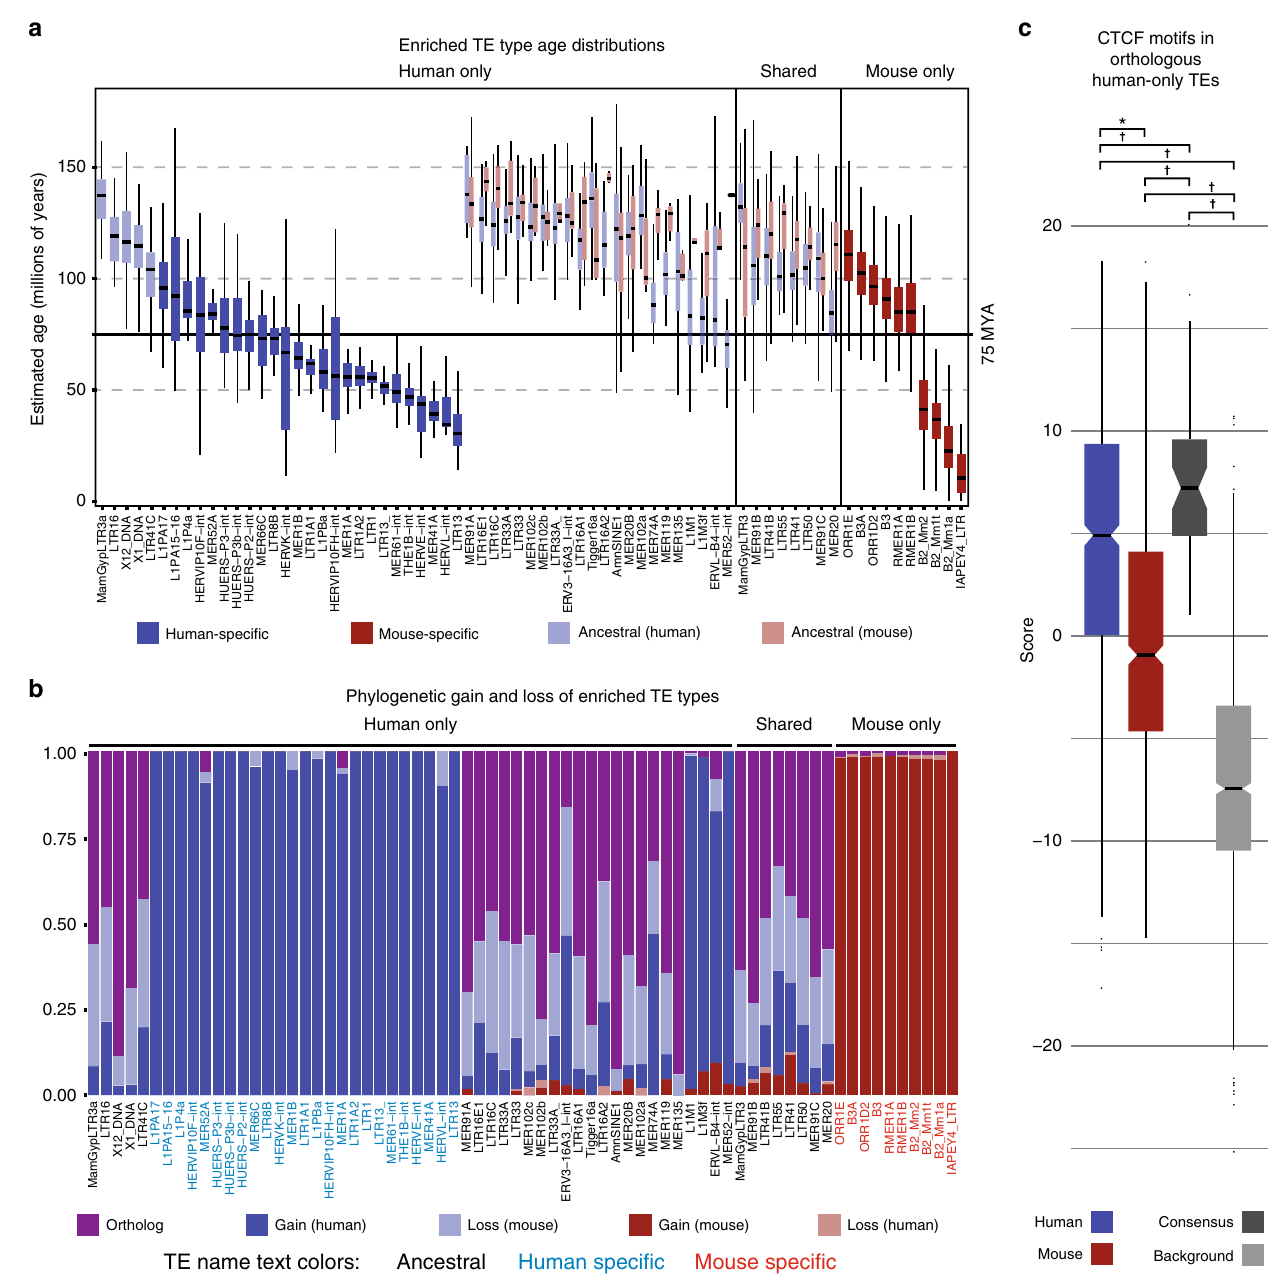
Mouse specificHuman specificTE name text colors: Fig. 3 Ages and phylogenetic histories of human-only CTCF-enriched TEs support mouse-speci fi c loss-of-function. a Estimated age distributions for CTCF-bound TE insertions of enriched types. Colors indicate the species-speci fi city of each TE type and score distributions are split by species where applicable. The solid black horizontal line marks the estimated primate – rodent divergence date. b Fraction of enriched TE insertions inferred as orthologous, or as evolutionary gains or losses on a given branch of the phylogeny. TE label colors indicate whether the given type is ancestral (black), human-speci fi c (blue), or mouse-speci fi c (red). c Maximum CTCF motif scores within human and mouse instances of ancestral, human-only TE types. TE Consensus sequences (a proxy for the ancestral TE sequence, dark gray) and length-matched background sequences (light gray) are shown for comparison. Log-odds scores greater than 1 indicate sequences matching the CTCF motif more than expected by chance. Hypothesis tests were used to assess signi fi cance of differences in all pairwise comparisons: * p < = 2.9e − 58 (one-sided Wilcoxon signed-rank test), † p < = 2.6e − 4 (one-sided Wilcoxon rank-sum test). Human, n = 852; mouse, n = 852; consensus, n = 54; background, n = 852. Boxplots in a and c are centered around the median, with upper and lower hinges, indicating the fi rst and third quartiles. Upper and lower whiskers extend from the hinge to the largest and smallest values within 1.5× the inter- quartile range from the hinge. Individual data points beyond the ends of the whiskers represent